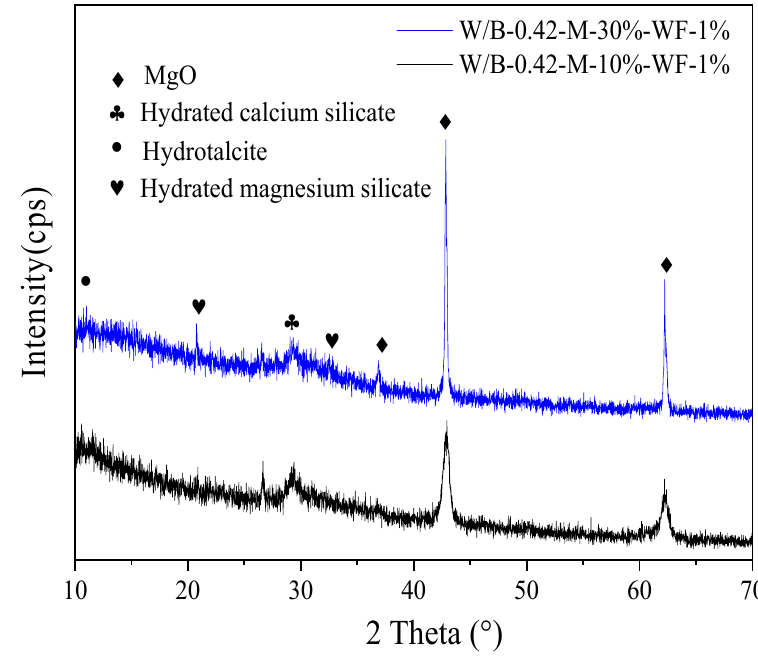
Figure 9. The X-ray diffraction (XRD) spectra curves.